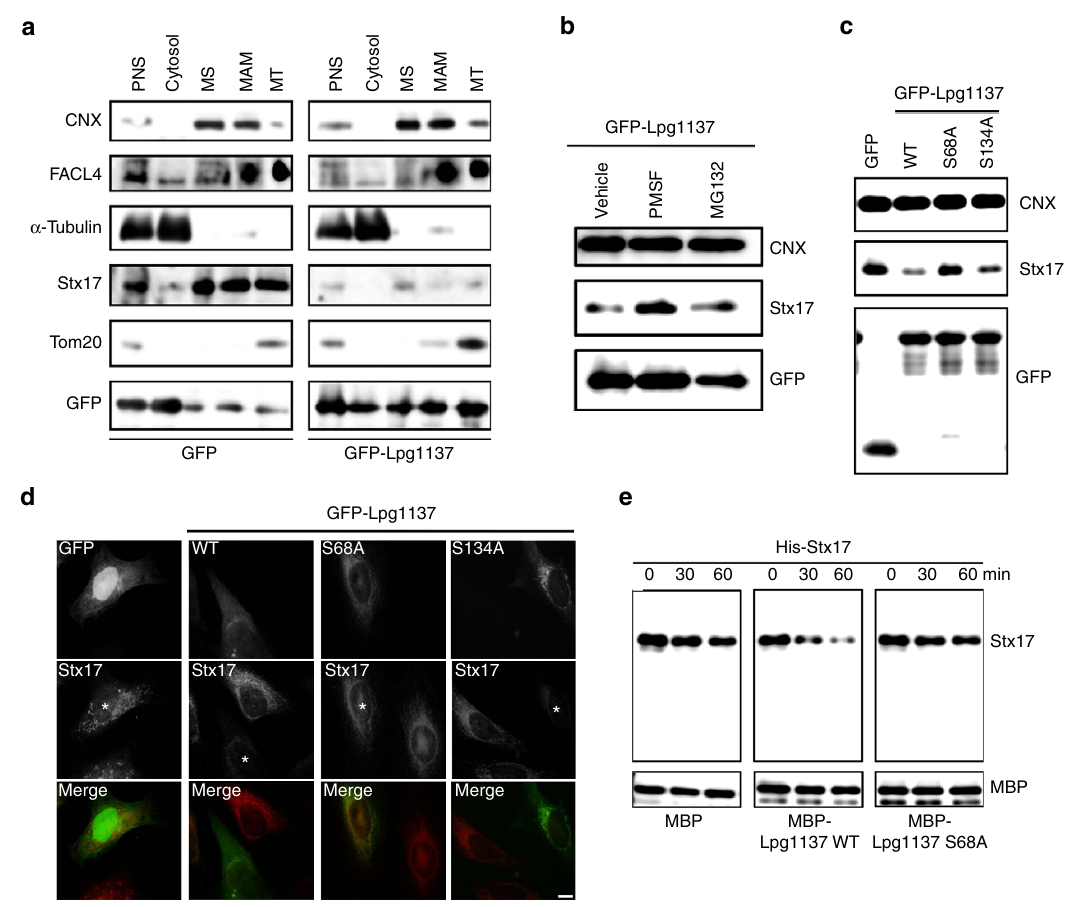
Figure 3 | Lpg1137 is a serine protease localized in MAM/mitochondria. ( a ) HeLa-Fc g RII cells were transfected with a plasmid encoding GFP (left) or GFP-Lpg1137 (right). At 24h after transfection, cells were subjected to subcellular fractionation, and equal amounts of fractions were analysed by IB with the indicated antibodies. MS and MTdenote microsomes and mitochondria, respectively. ( b ) HeLa-Fc g RII cells were transfected with GFP-Lpg1137. At 4h after transfection, DMSO (Vehicle), PMSF (1mM) or MG132 (1 m M) was added to cells, and the cells were incubated for 20h. Equal amounts of cell lysates were analysed by IB with the indicated antibodies. ( c , d ) HeLa-Fc g RII cells were transfected with one of the indicated plasmids, and after 24h equal amounts of lysates were analysed by IB with the ( c ) indicated antibodies. Alternatively, cells were fixed and stained with ( d ) an anti-Stx17